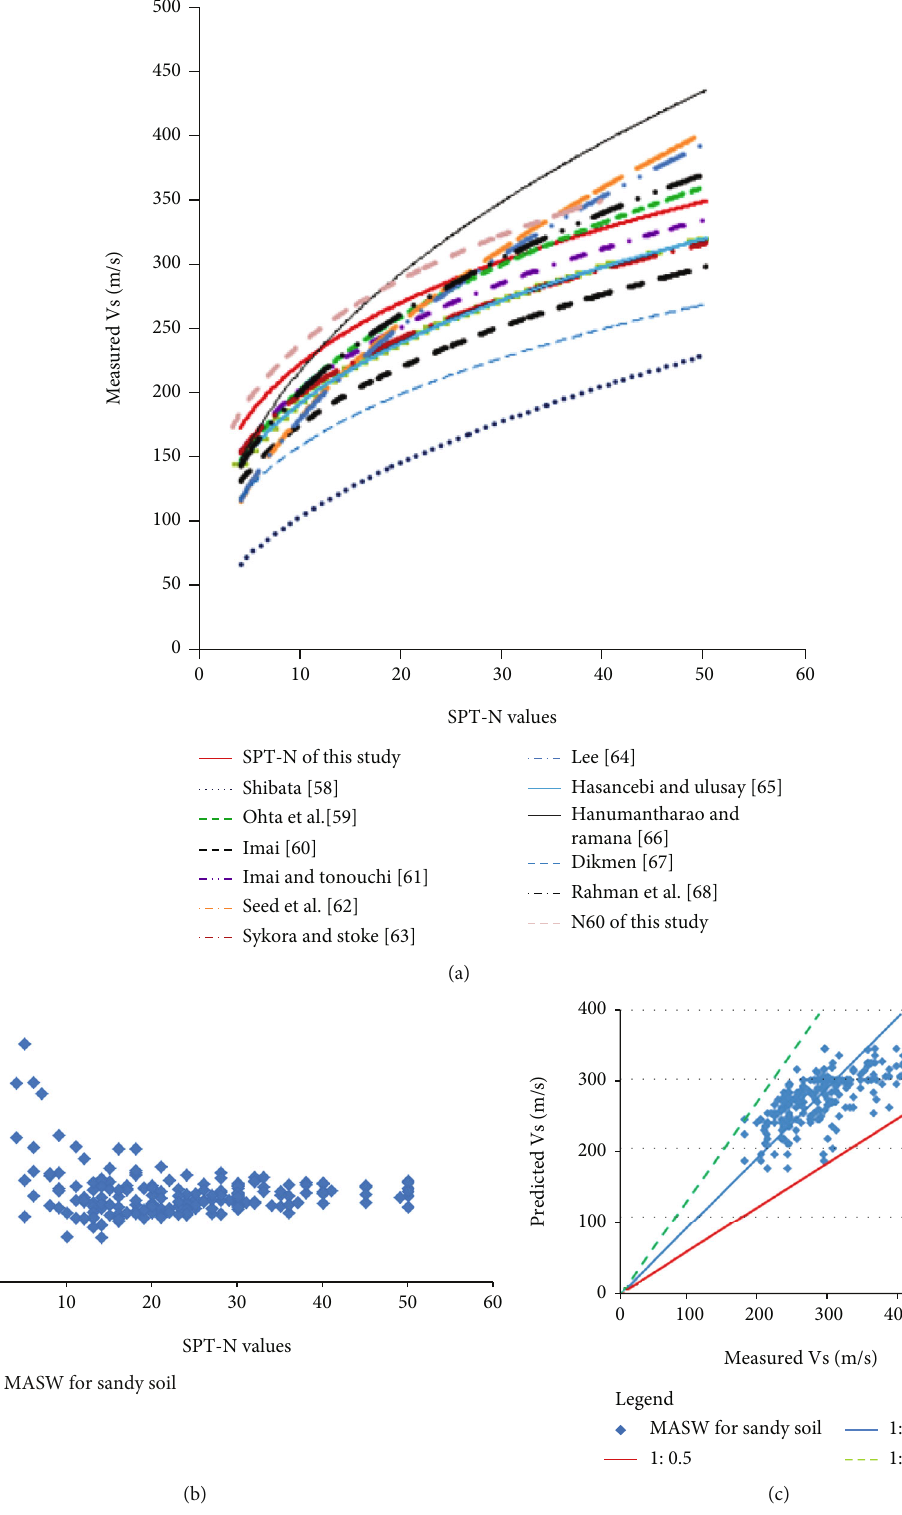
Figure 15: (a) correlations between Vs, SPT-N and N60 of the current and previous studies, (b) Cd graphs of sandy soil, and (c) comparison between predicted and measured Vs for sandy